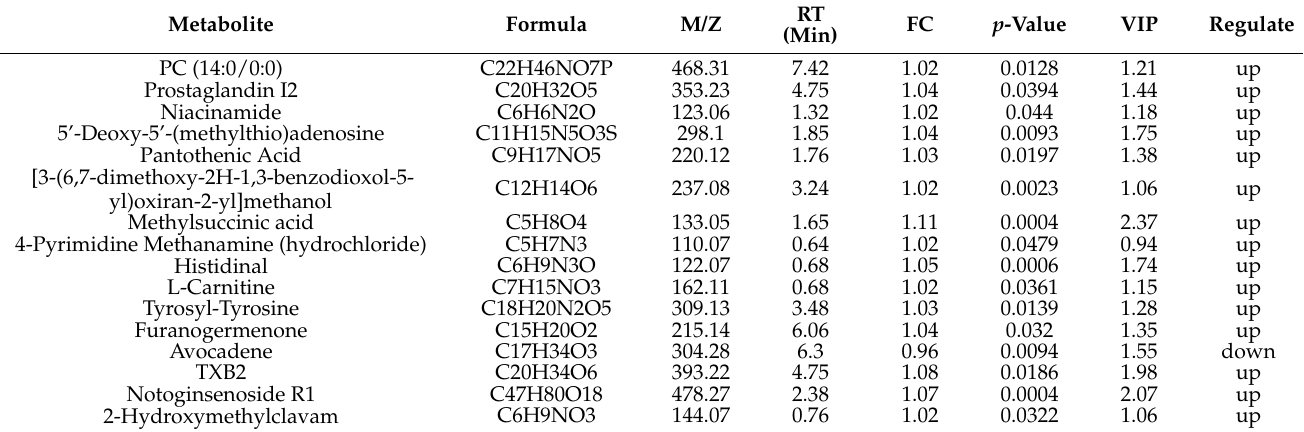
Table 1. Positively identified significantly differentially expressed metabolites in the dermal papilla cells after copper treatment under positive ion mode ( n = 6).